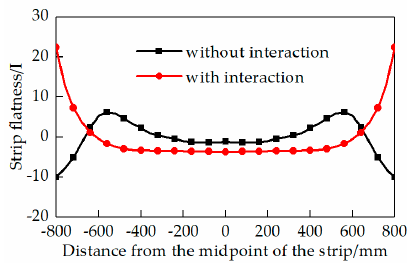
Figure 5. Strip flatness distribution with or without fluid–structure interaction.